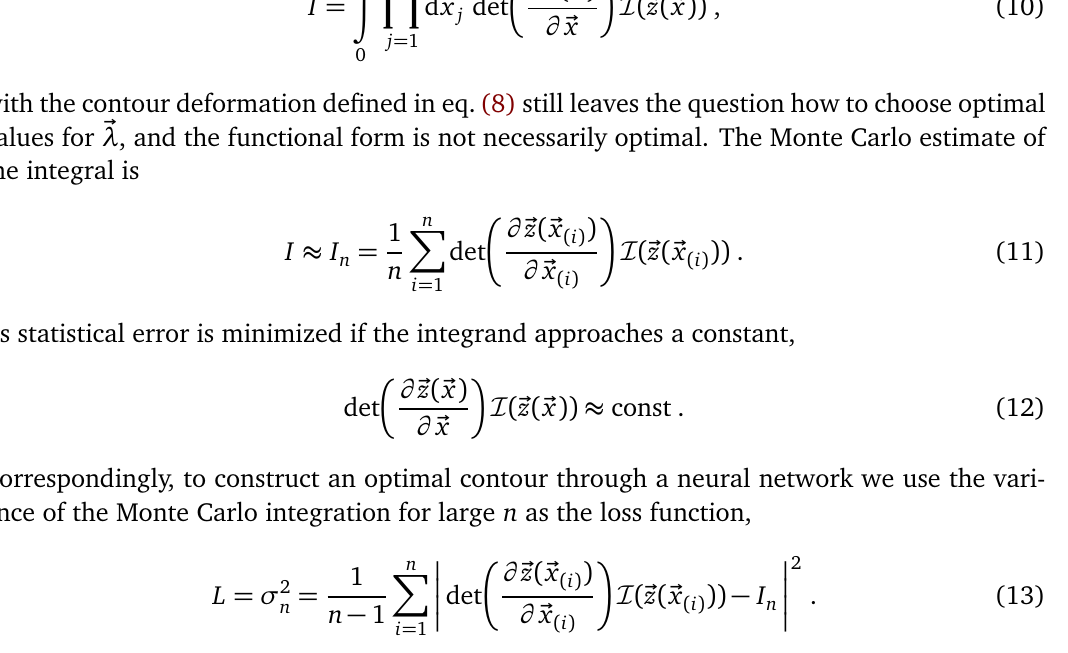
are shown. The plots end i )